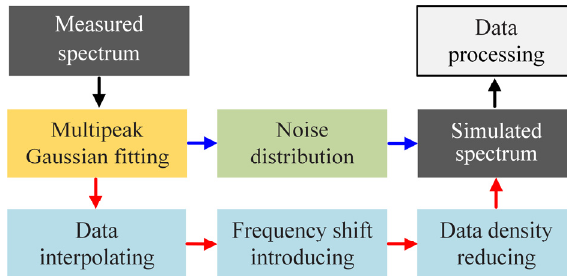
Figure 3. Procedure used for the numerical experiments.